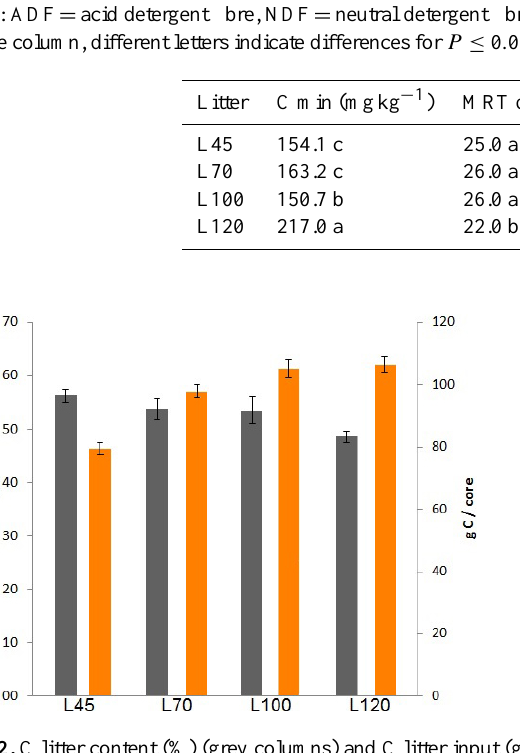
Figure 2. C litter content (%) (grey columns) and C litter input (g) for each core (orange columns) in L45, L70, L100 and L120 treat-